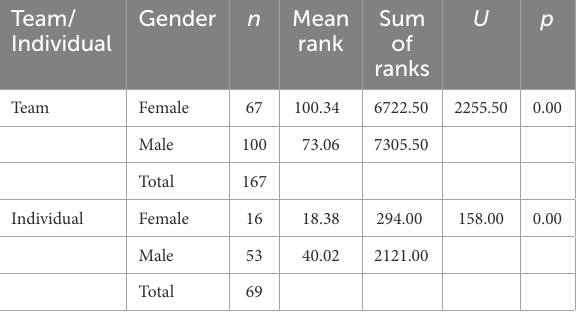
TABLE 7 Mann–Whitney U test results of coaches’ scores on positive feedback behaviors by gender. Team/ Individual